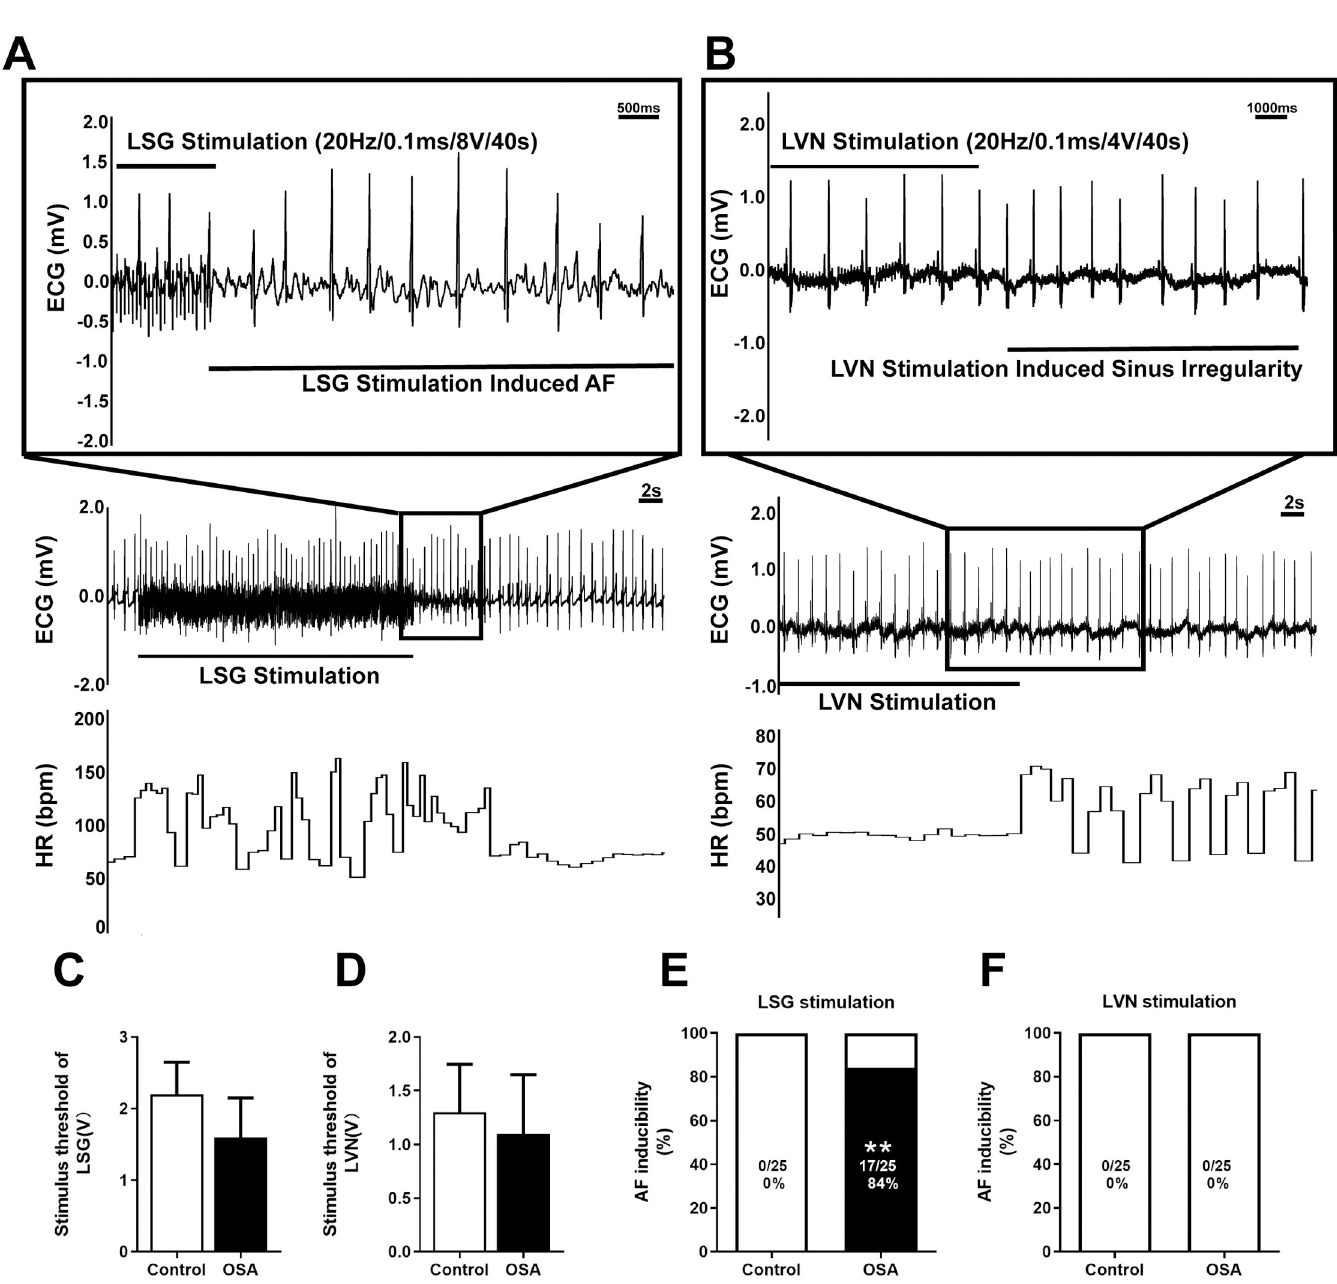
Fig 9. AF inducibility by LSG and LVN stimulation. (A) An example of induced AF in the OSA group under LSG stimulation. (B) An example of induced sinus arrhythmia in the OSA group under LVN stimulation. (C, D) Comparison of stimulus threshold of LSG and LVN. (E, F) Comparison of the AF inducibility under LSG and LVN stimulation. Abbreviations: LSG: left stellate ganglion; LVN: left vagal nerve. � P < 0.05, �� P < 0.01 compared to control group.